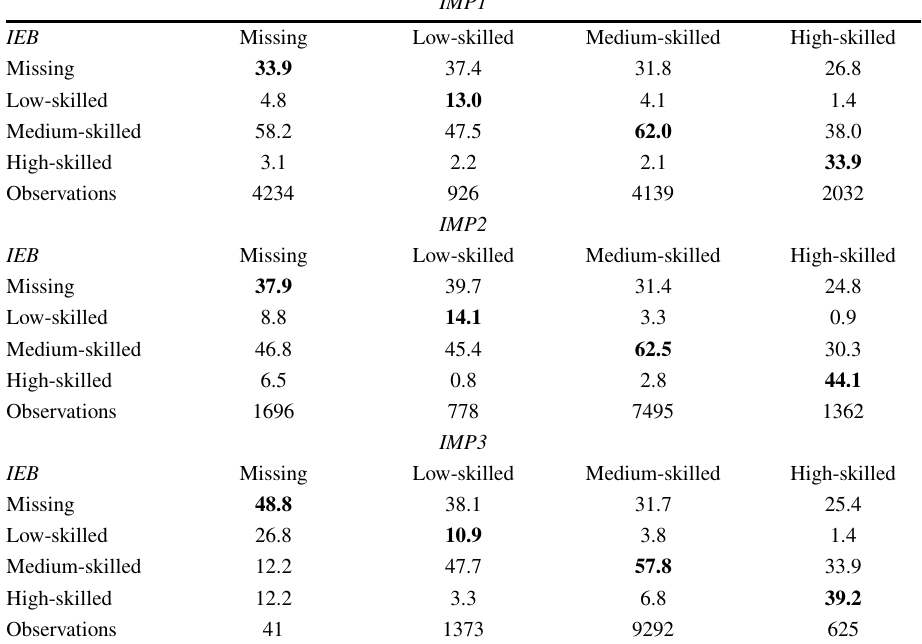
Table 11 Cross tabulation of IMP1 , IMP2 and IMP3 vs. IEB